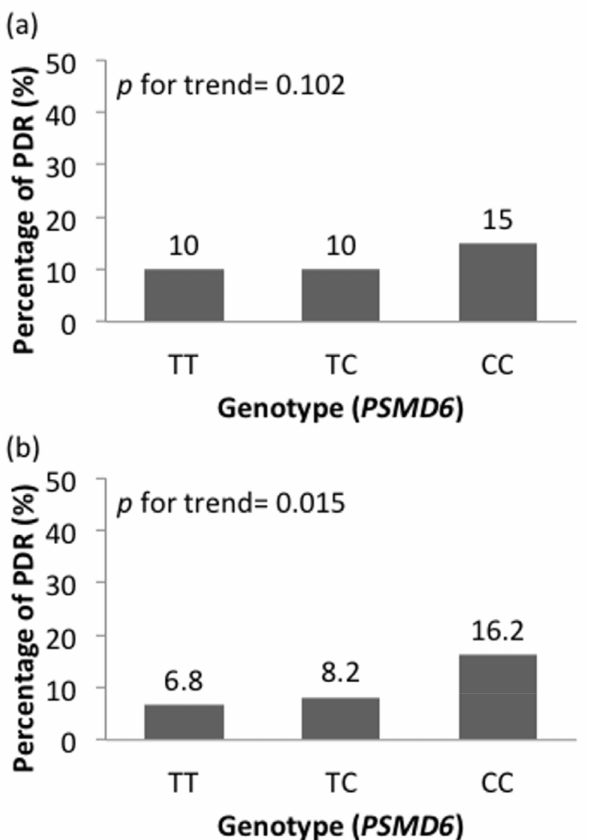
Figure 4. The effect of thiazolidinediones (TZD) usage on the prevalence of proliferative diabetic retinopathy (PDR) in T2DM patients of PSMD6 rs831571 variant. The bar chart indicates the PDR prevalence in patients ( a ) without using and ( b ) using TZD according to genotype of PSMD6